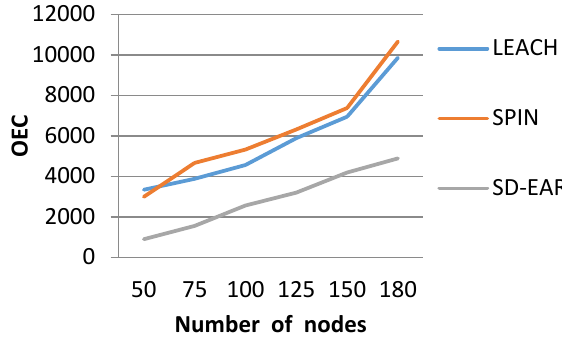
Figure 11. Overall Message Cost (OMC) vs. number of nodes.